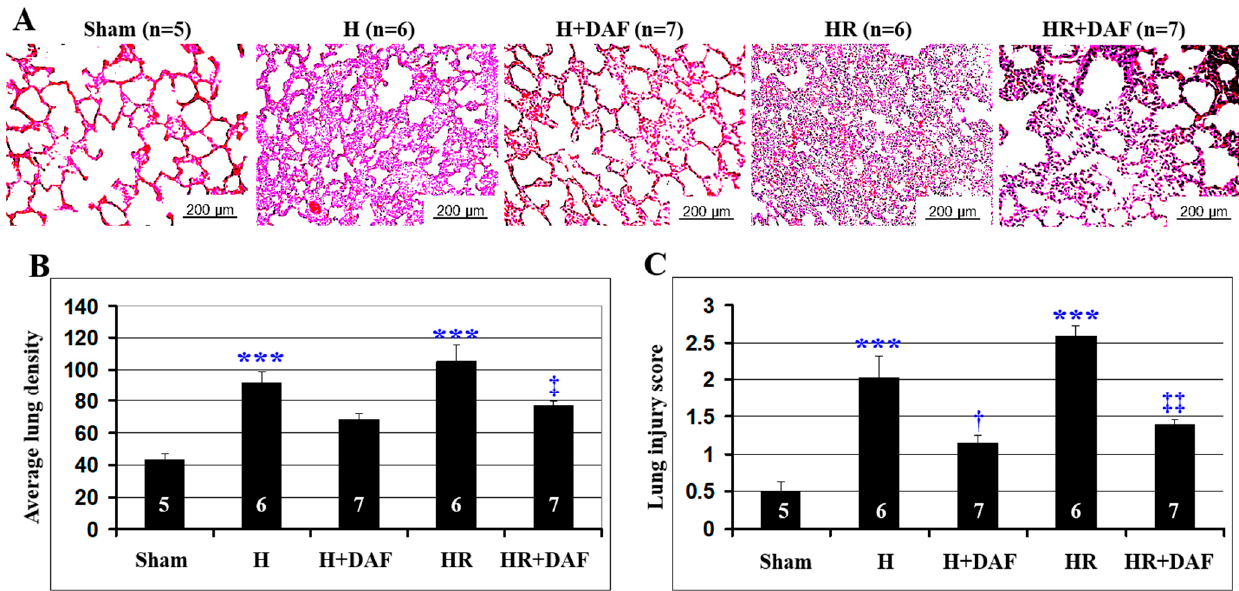
Figure 2. DAF attenuates hemorrhage ‒ induced lung injury in rats. Histopathological changes of the lung on H&E slides. Representative photomicrographs are shown. ( A ) Quantification of the staining intensity of the lung tissue from the enrolled rats was performed using ImageJ software as described in Materials and Methods. ( B ) Cumulative histopathological lung injury scores for the sham, H, H + DAF, HR, and HR + DAF. ( C ) The numbers (5, 6, 7) in the figures mark the number of rats/tested samples per group. Original magnification ×400. Scale bar = 200 μ m. *** p < 0.001 vs. sham; † p < 0.05 vs. H; ‡ p < 0.05 and ‡‡ p < 0.01 vs. HR (one ‒ way ANOVA followed by Tukey’s test).